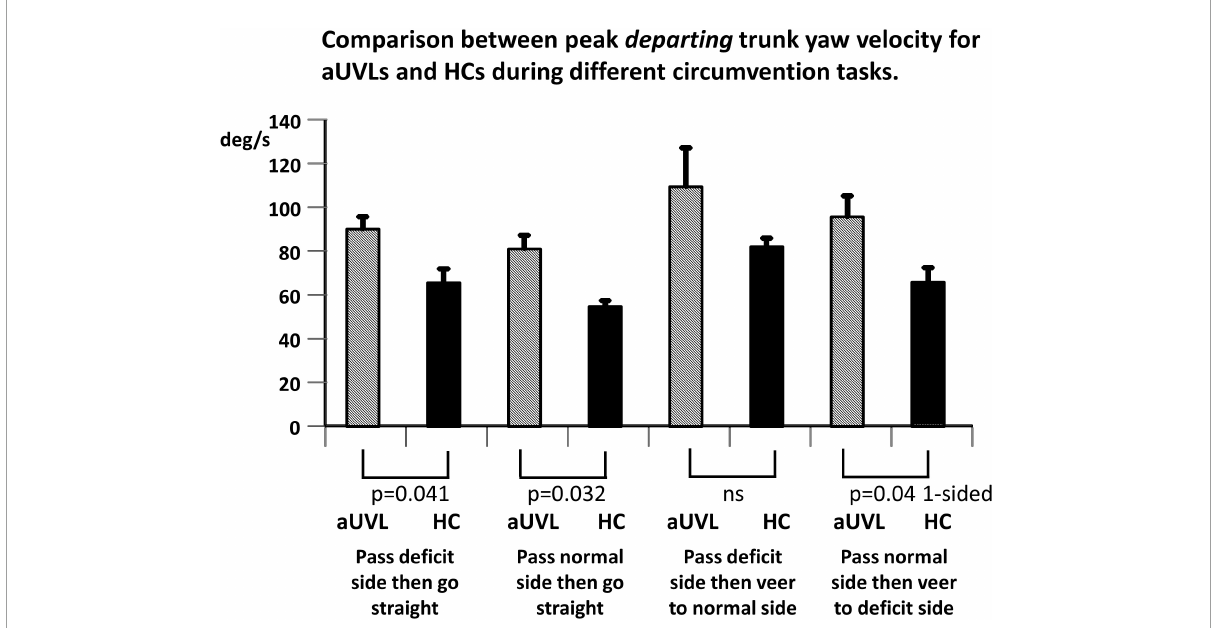
FIGURE6 Comparison between mean peak departing from the obstacle peak yaw angular velocities for patients with aUVL and HCs during different circumvention tasks, as listed below the column plots. The height of the column represents the mean population value, and the vertical bar, the SEM. The pair-wise levels of significant differences are indicated below the columns. Note the differences between populations are most significant for the tasks continuing along the same trajectory (no veering).